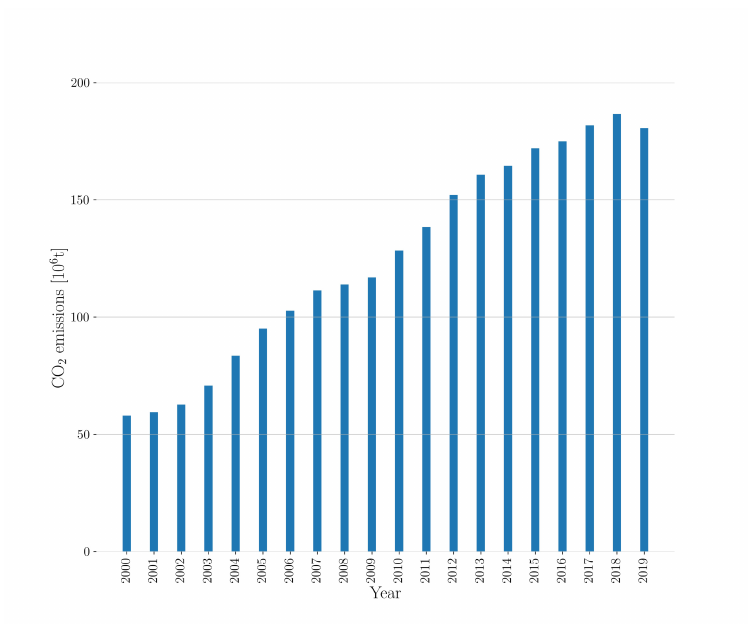
Figure 1. Carbon dioxide emissions of China’s logistics industry from 2000 to